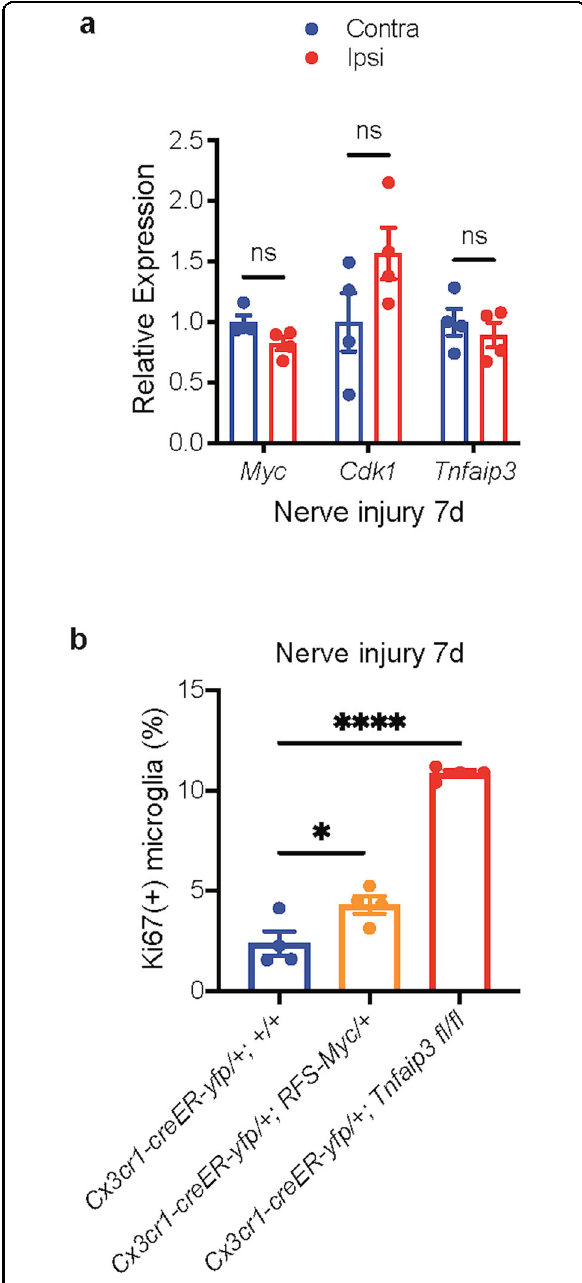
Fig. 7 The termination of microglia proliferation. a qRT-PCR of sorted lumbar cord microglia from Cx3cr1-creER-yfp/ + ; + / + animals. The expression levels of Myc, Cdk1 , and Tnfaip3 of lumbar cord microglia returned to control contralateral levels 7 days after nerve injury. b Quanti fi cation of Ki67 fl ow cytometry. Overexpression of Myc in adult microglia or deletion of Tnfaip3 from adult microglia prevented the termination of lumbar cord microglia proliferation 7 days after nerve injury. Analyses are one-way ANOVA with Tukey ’ s multiple-comparison test ( b ) or two-way ANOVA with Sidak ’ s multiple- comparison test ( a ), n = 4 – 6, means ± SEM, * P < 0.05, ** P < 0.01, ***